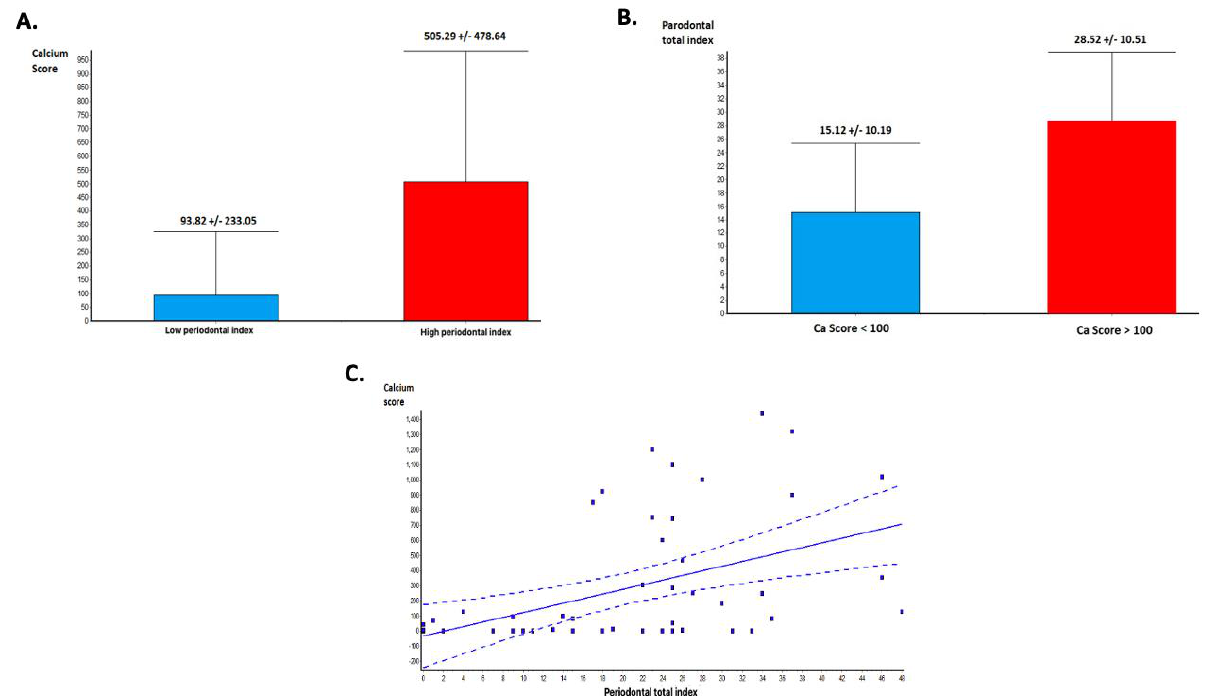
Figure 2. Periodontal disease and coronary calcium score: ( A ) Calcium score and periodontal index (PI). Calcium score is significantly higher in patients with advanced periodontal disease (PD). ( B ) PI is significantly higher in patients with high calcium scores. ( C ) Linear regression analysis demonstrating a significant association between total calcium score and periodontal index.